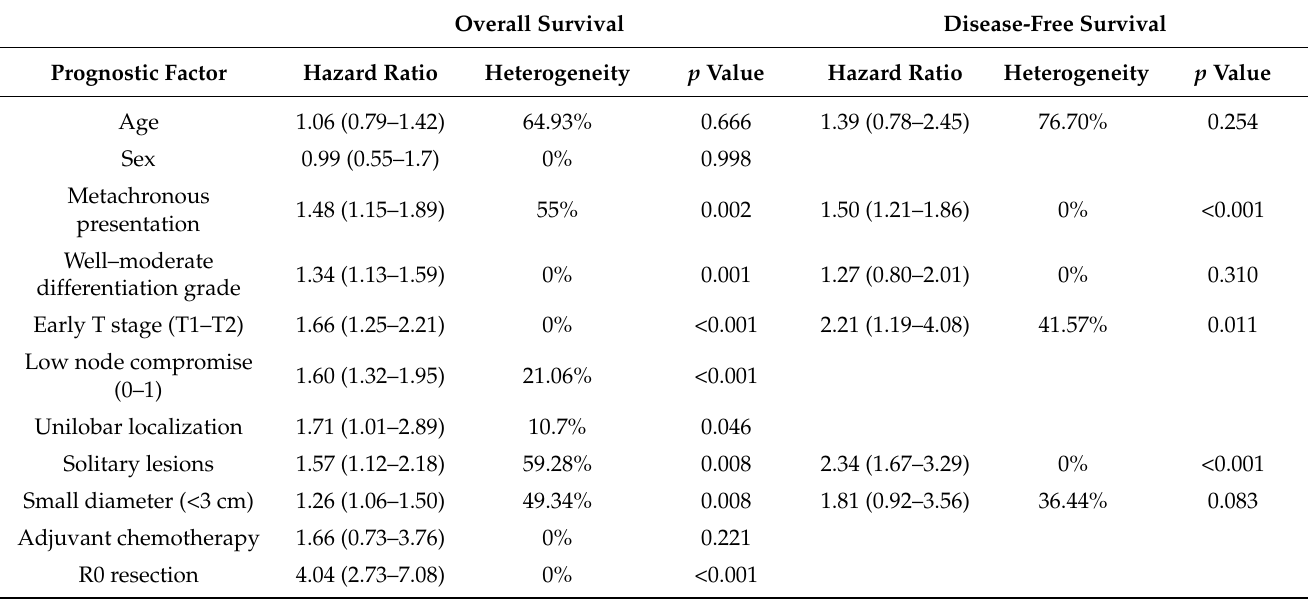
Table 4. Prognostic associations with survival outcomes.